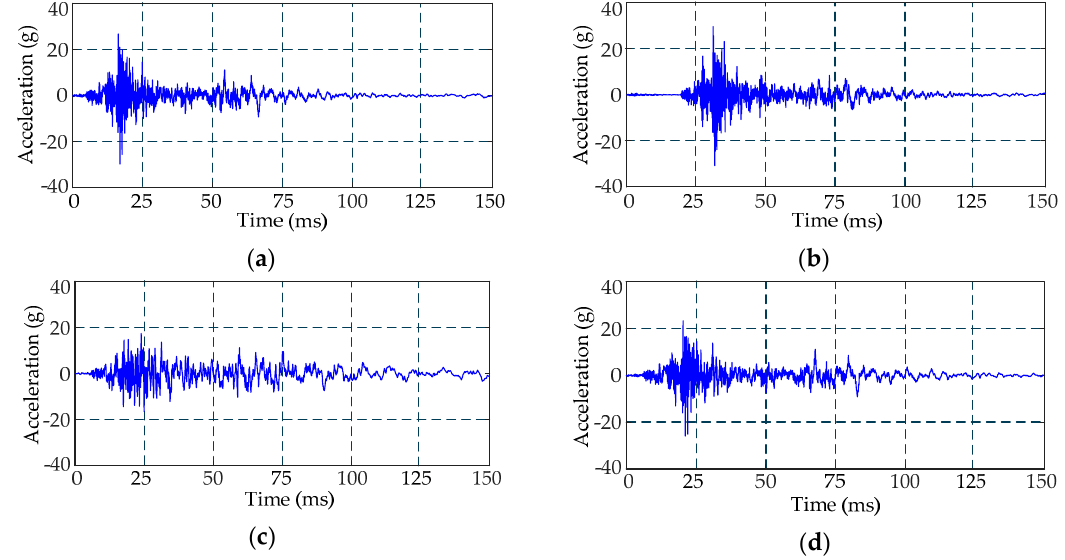
Figure 8. Waveforms of four types of vibration signals. ( a ) Normal condition; ( b ) Fault I; ( c ) Fault II; ( d ) Fault III.